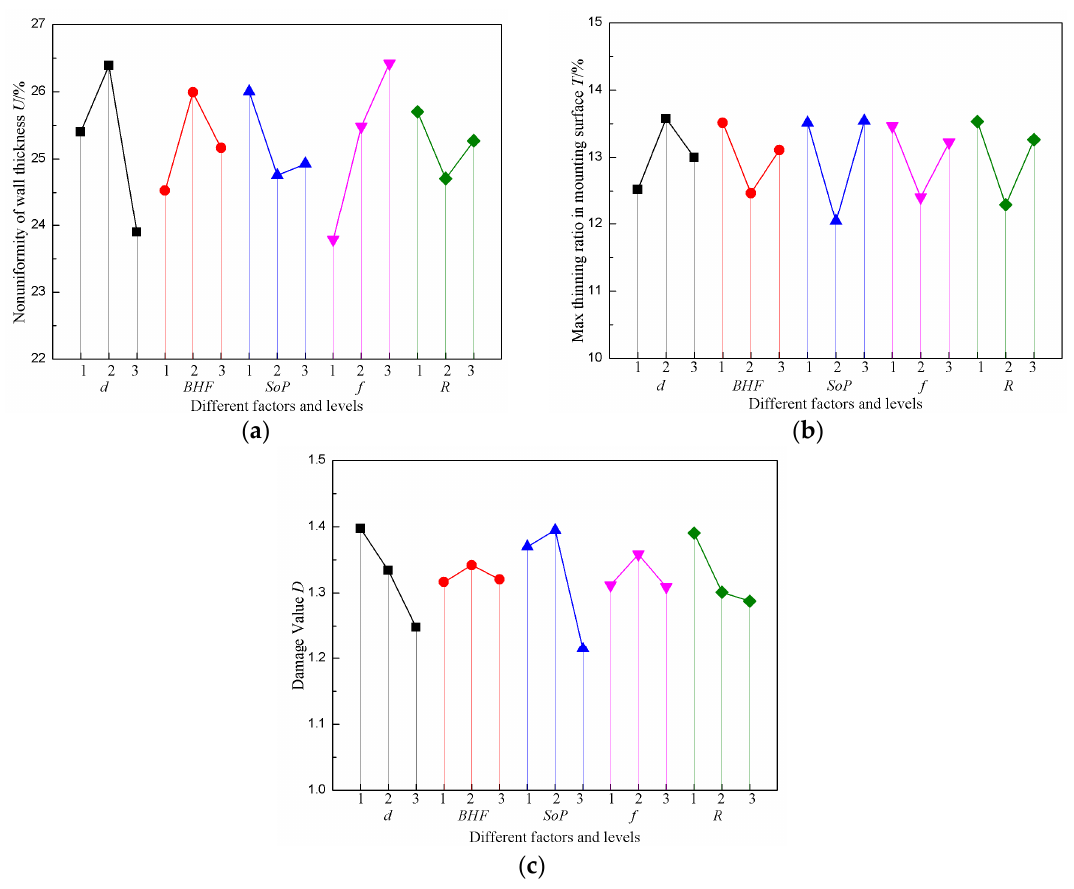
Figure 9. Influences of different factors on U , T , D : ( a ) on nonuniformity of wall thickness U ; ( b ) on the maximum thinning ratio in mounting zone T ; ( c ) on the value of damage D .